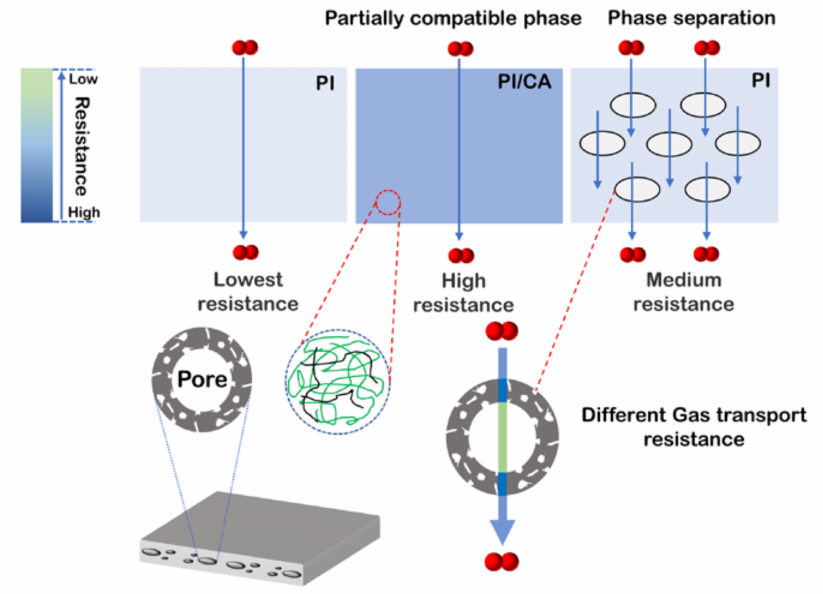
Figure 10. The mechanism of gas permeability of different phase structures for composite membranes after 350 ◦ C treatment.